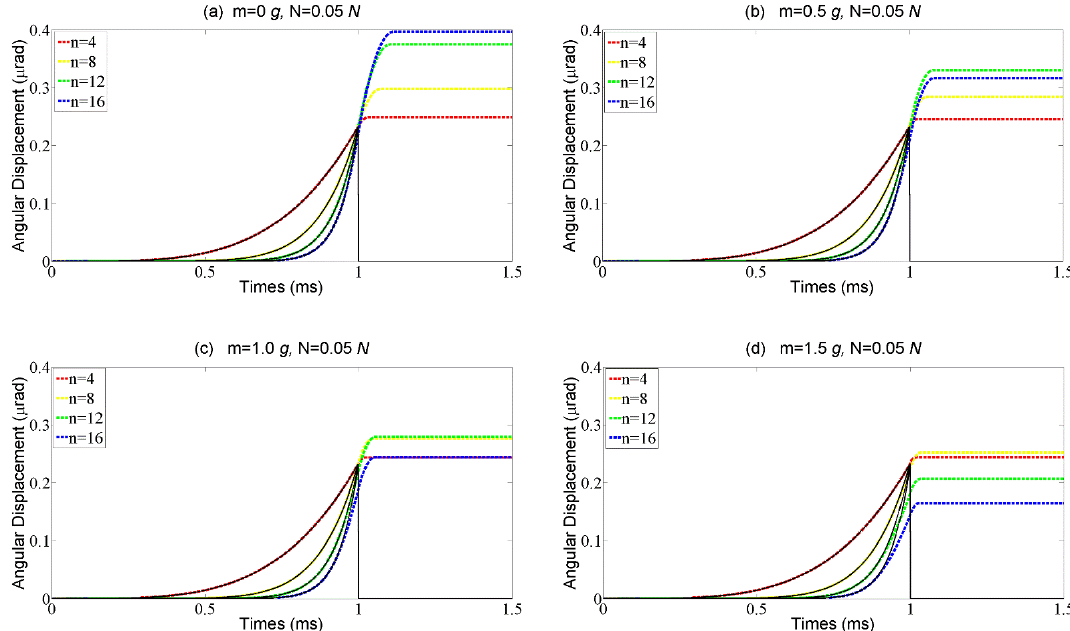
Figure 7. The rotor angular displacement vs different driving signals described by the base numbers with four external loads, ( a ) m = 0 g; ( b ) m = 0.5 g; ( c ) m = 1 g; ( d ) m = 1.5 g.